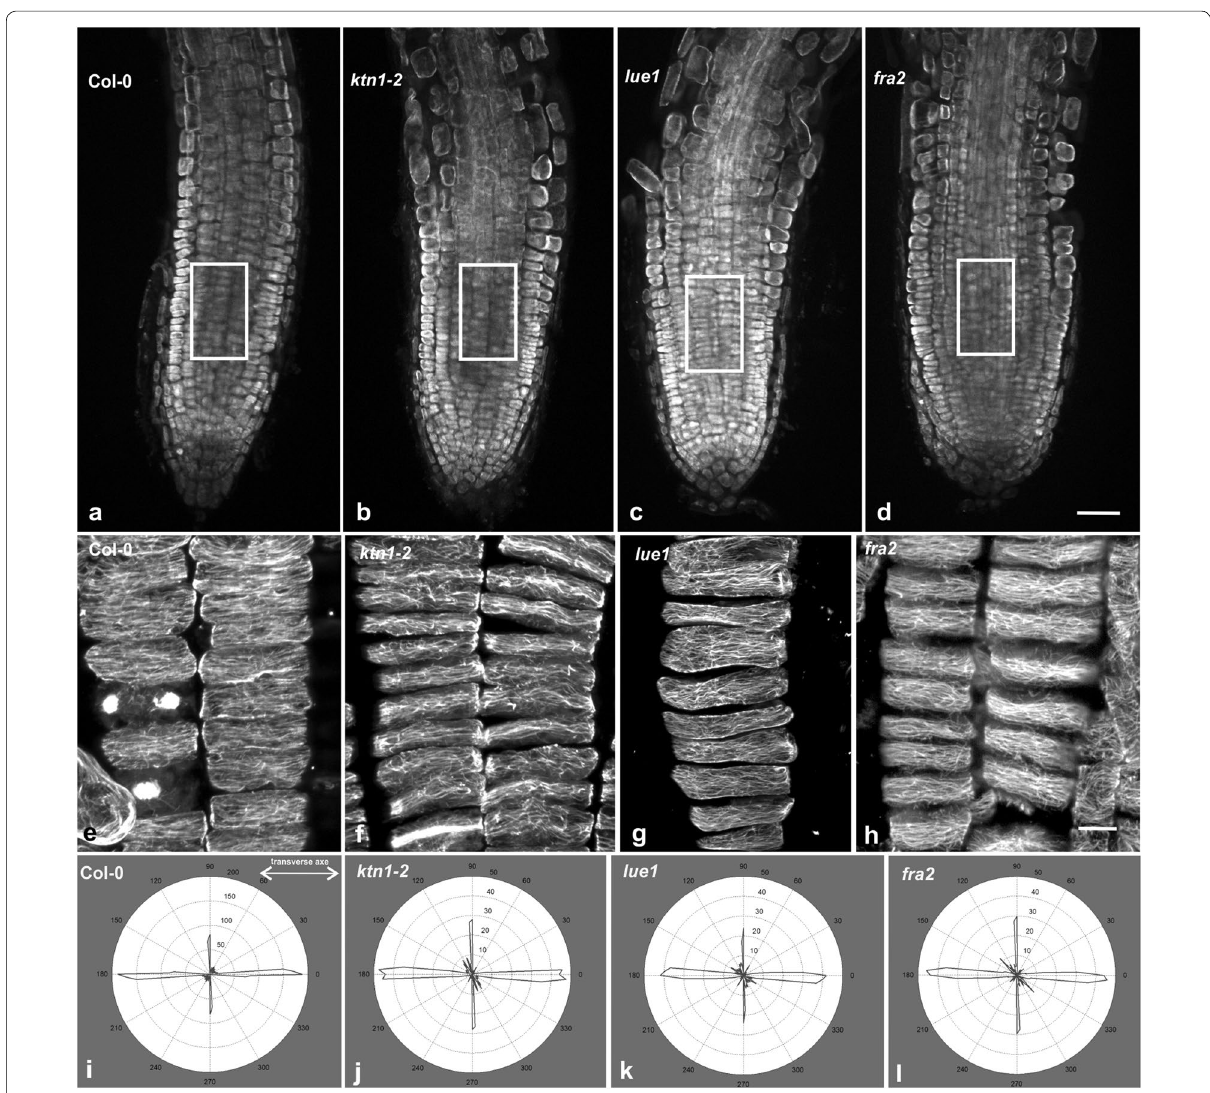
Fig. 4 Cortical microtubule orientation in cortex cells of wild‑type ( a , e ) and p60‑katanin mutants ( b – d , f – h ). All high magnification images ( e – h ) are maximum projections of serial CLSM sections through the cortical cytoplasm. Cortex cell files, derived from the areas defined by rectangular frames on low magnification images ( a – d ), were released after application of gentle pressure on the whole mount root specimens. Fairly transverse cortical microtubules can be observed in Col‑0 cells ( e ). In ktn1 ‑ 2 ( f ), lue1 ( g ) and fra2 ( h ), though a general transverse pattern exists, several microtubules exhibit random orientation, while foci of microtubule convergence can be discerned as well. Representative decipher‑graphs of microtubule alignment in meristematic cortex cells of Col‑0 ( i ), ktn1 ‑ 2 ( j ), lue1 ( k ) and fra2 ( l ). Generally, transverse microtubule orientation prevailed in all the cases (doubled‑headed arrow). However, in the katanin mutants an increase in the frequency of longitudinal and/or randomly oriented microtubules was noticed. Scale bars 50 μm ( a – d ), 10 μm ( e – h